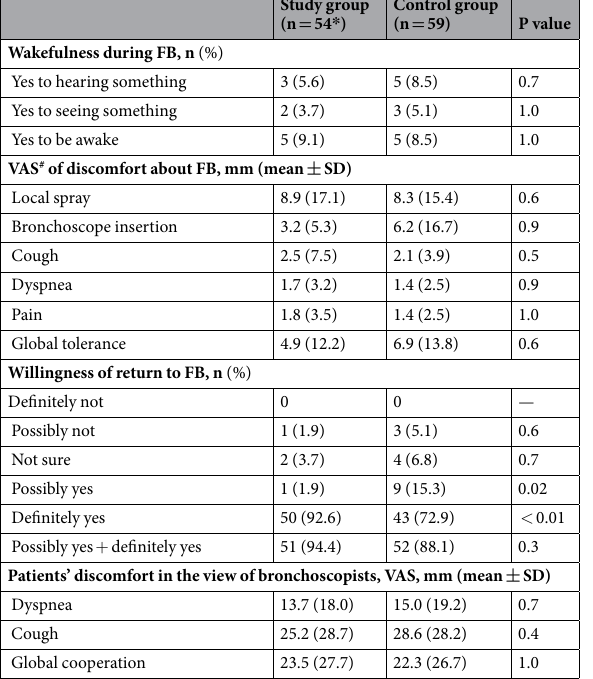
Table 4. Patient perception and tolerance about flexible bronchoscopy (FB). * One subject refused answer the questions. # VAS: 100 mm visual analogue scale (0: no bother, 100: worst intolerable). FB: flexible